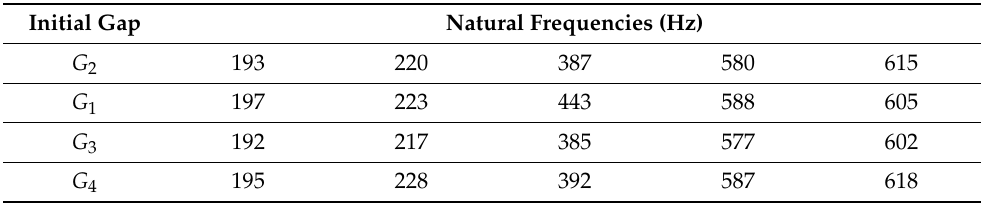
Table 2. Natural frequencies for different initial